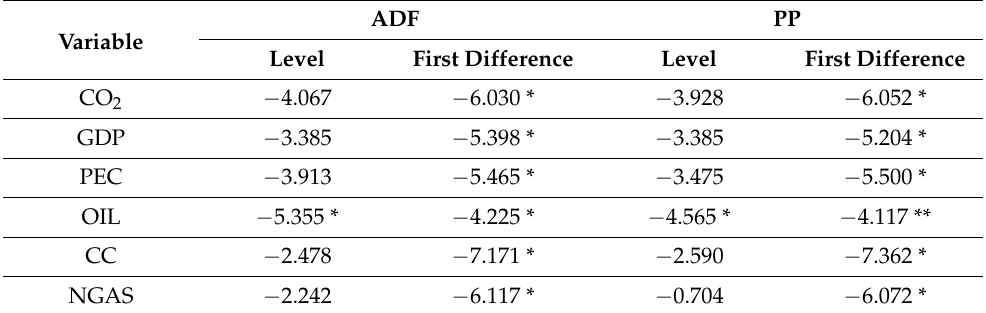
Table 3. Conventional unit root outcome.